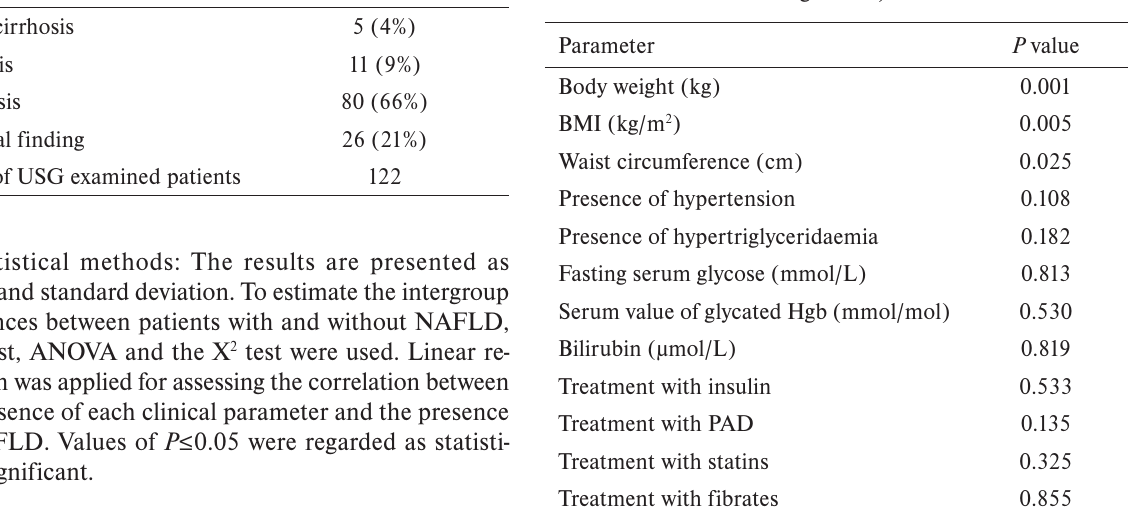
*Statistical difference between patients with NAFLD and those without NAFLD. Table 3. Ultrasound findings in patients with DM2. Table 4. Correlation between clinical parameters and the presence of NAFLD in the group of NAFLD patients (linear